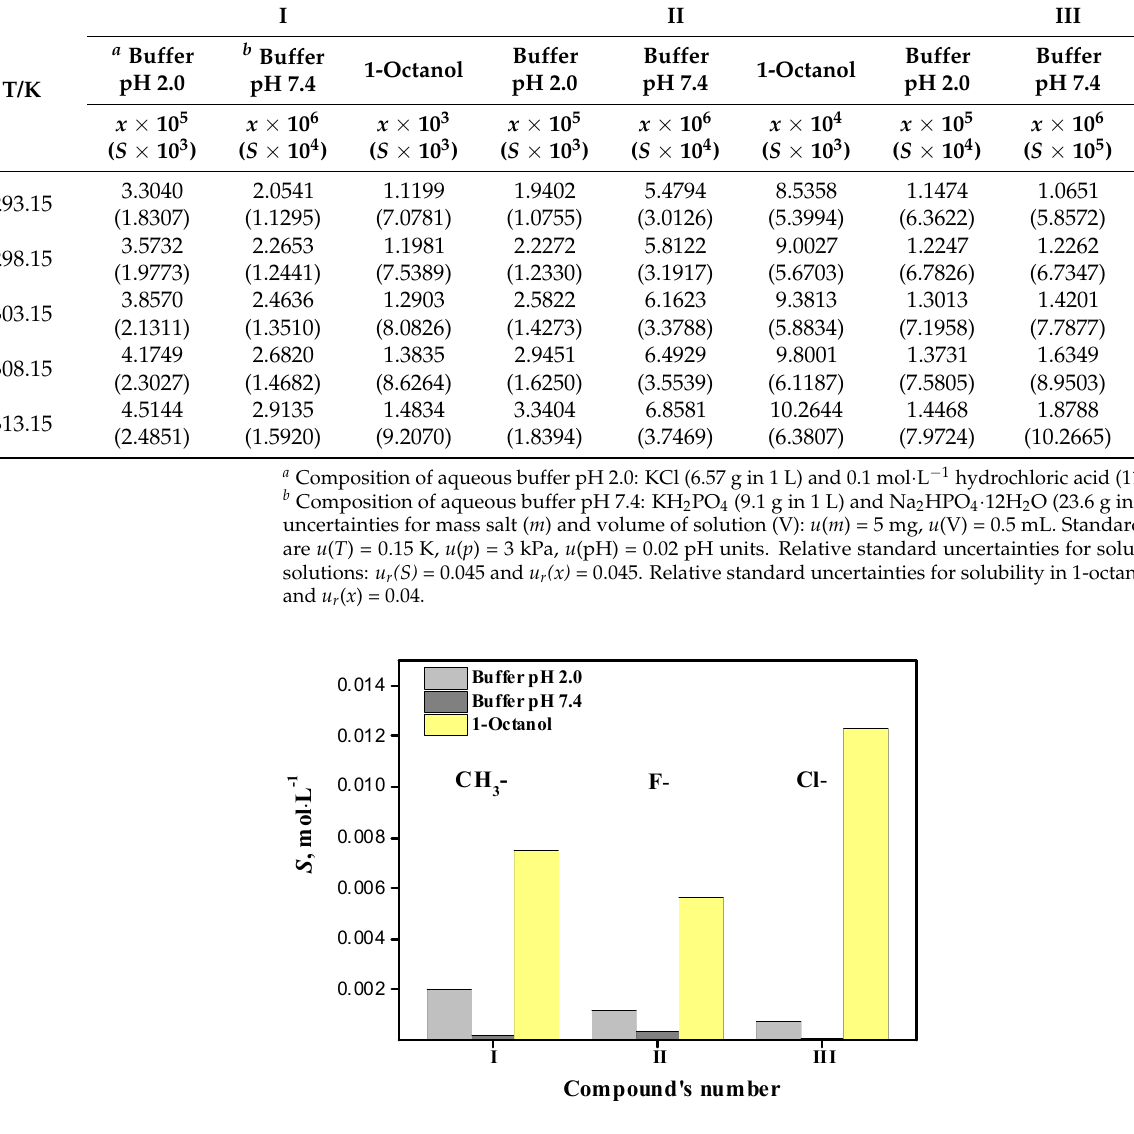
Figure 3. Solubility data of compounds I − III in selected solvents at 298.15 K.